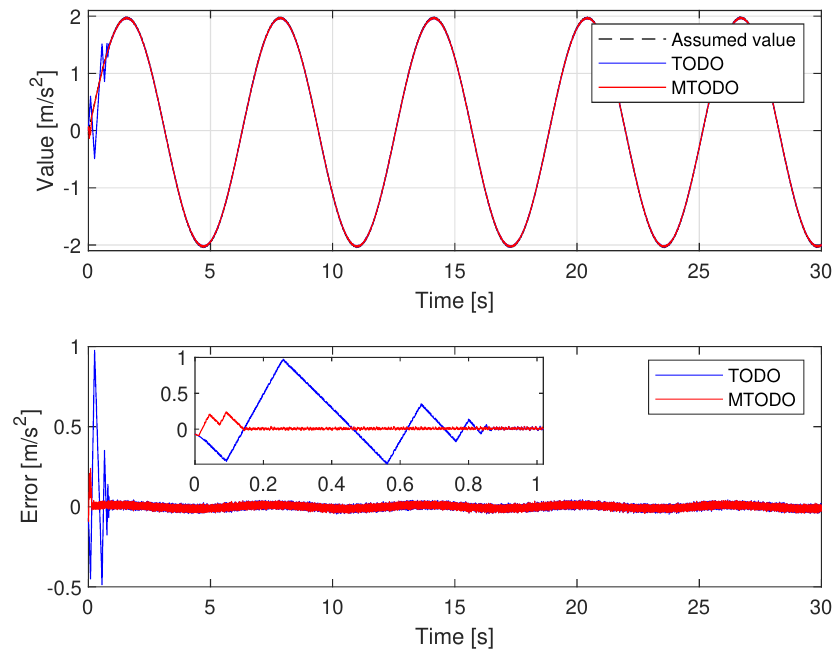
Figure 5. Time evolution of observer